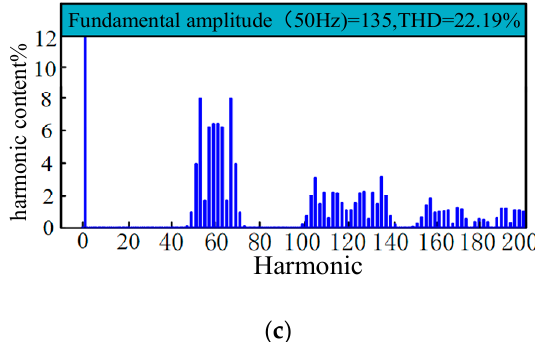
Figure 11. Spectrum of phase voltages under three strategies. ( a ) Phase voltage spectrum of hybrid frequency strategy. ( b ) Phase voltage spectrum of unipolar LS-PWM strategy. ( c ) Phase voltage spectrum of unipolar LS-PWM double frequency strategy.